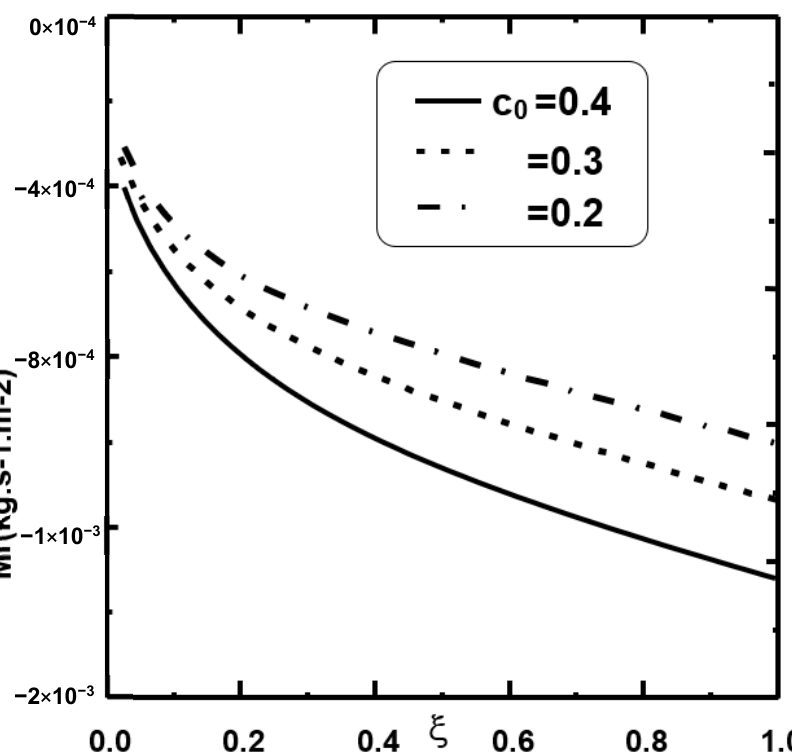
Figure 10. Effect of inlet vapor mass fraction on the cumulated condensation rate: T 0 = 293.15 K, T 0L = 293.15 K, q 1 = − 1000 W/m 2 , T w = 293.15 K, Φ 0 = 0.03, u 0 = 1 m/s, m 0L = 0.015 kg/m.s, H = 1 m, d = 0.015 m, p 0 = 1 atm.